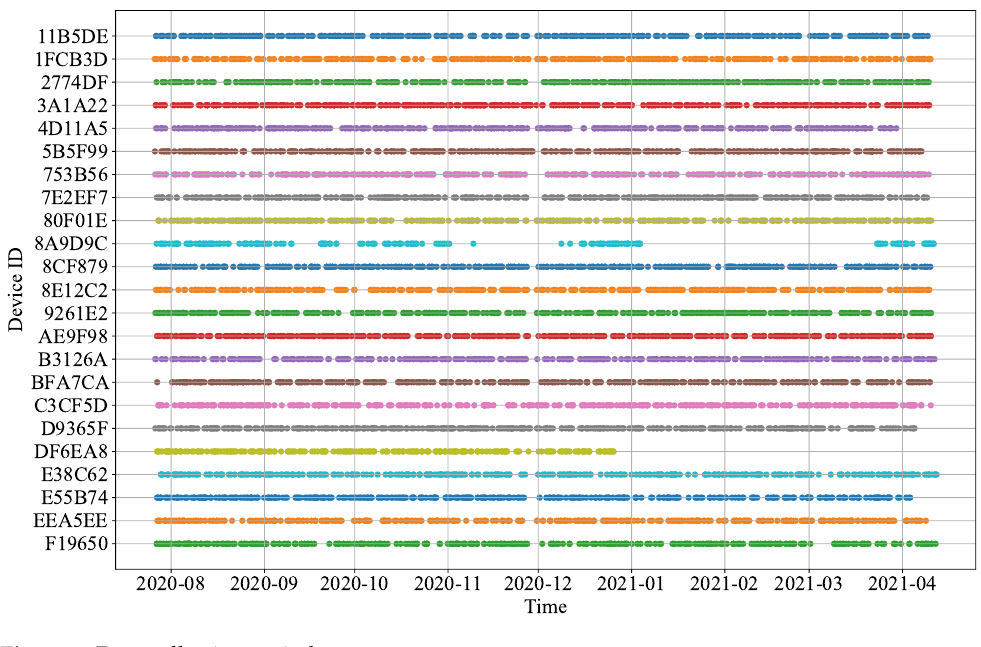
Figure 2. Data collection period.